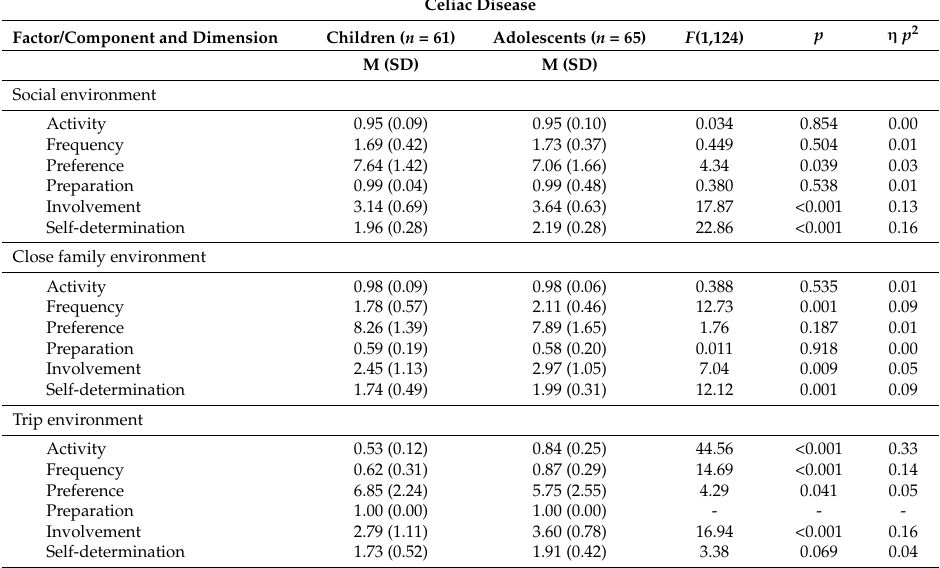
Table 5. Comparison between children (8–11) and adolescents (12–18) with CD across the six CD-Chart dimensions